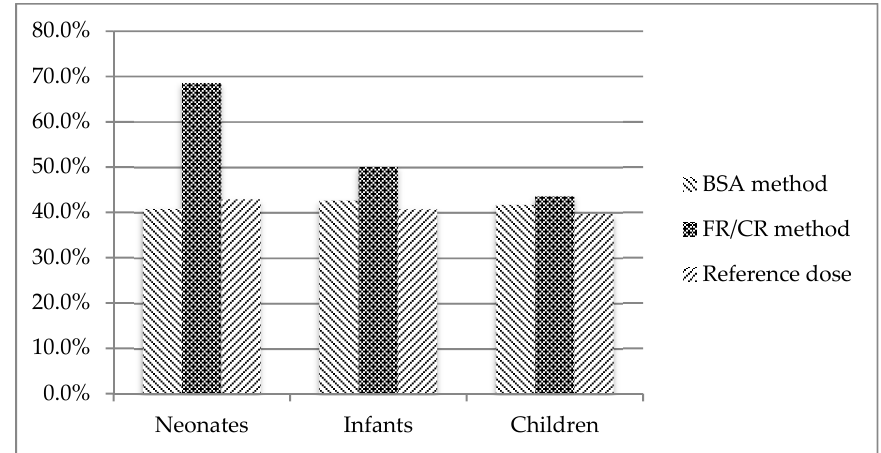
Figure 1. Distribution of high solubility drugs for each age group (FR: Fried’s Rule, CR: Clark’s Rule).